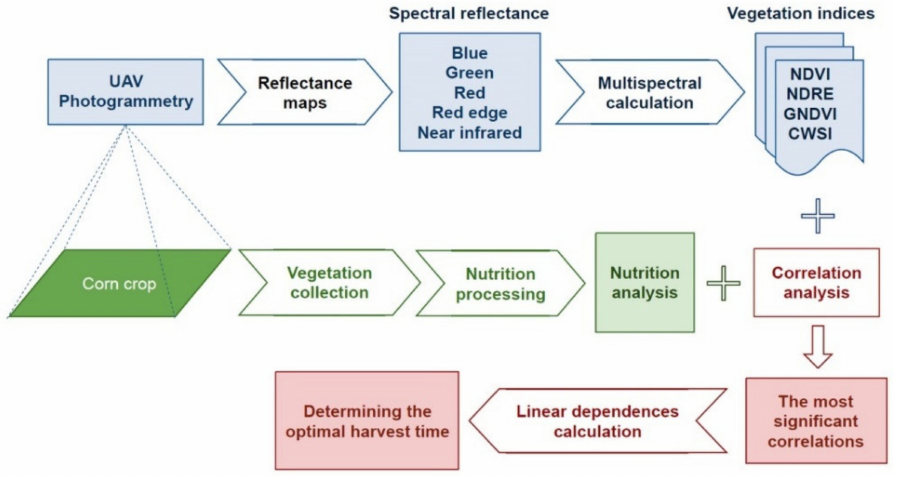
Figure 1. A block diagram defining the data collection and